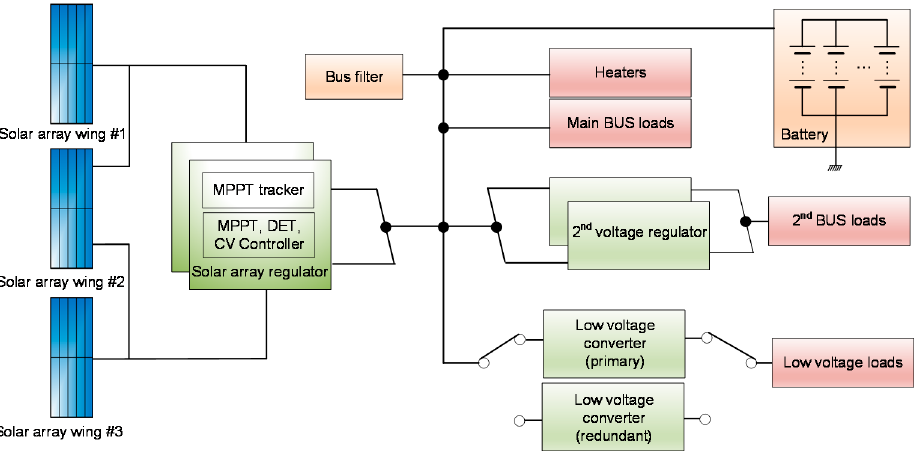
Figure 1. KOMPSAT-3A electrical power system structure.